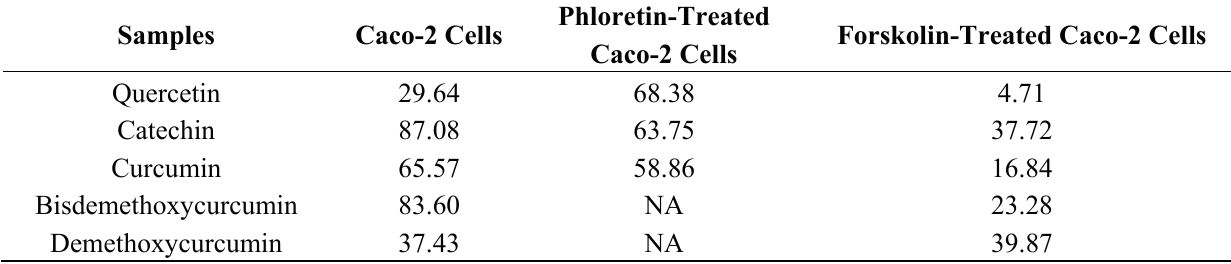
Table 1. IC 50 values ( μ g/mL) for the inhibition of fructose uptake of five signature components in naive, phloretin-treated and forskolin-treated Caco-2